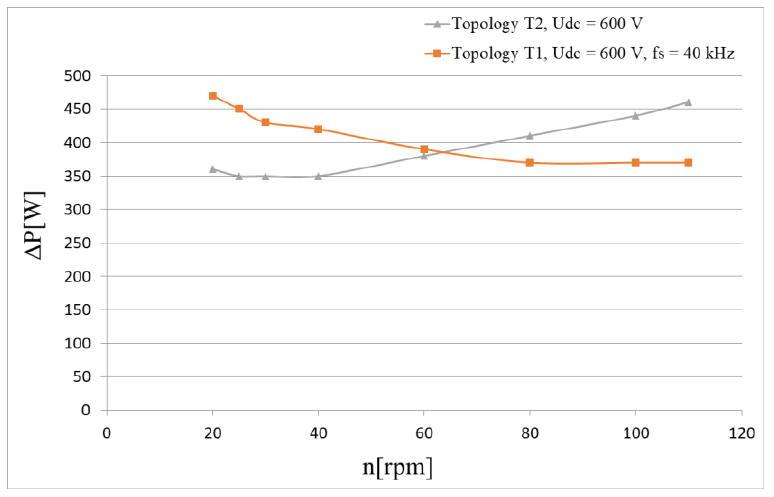
Figure 8. Power losses in the T1 and T2 topologies at U dc = 600 V.